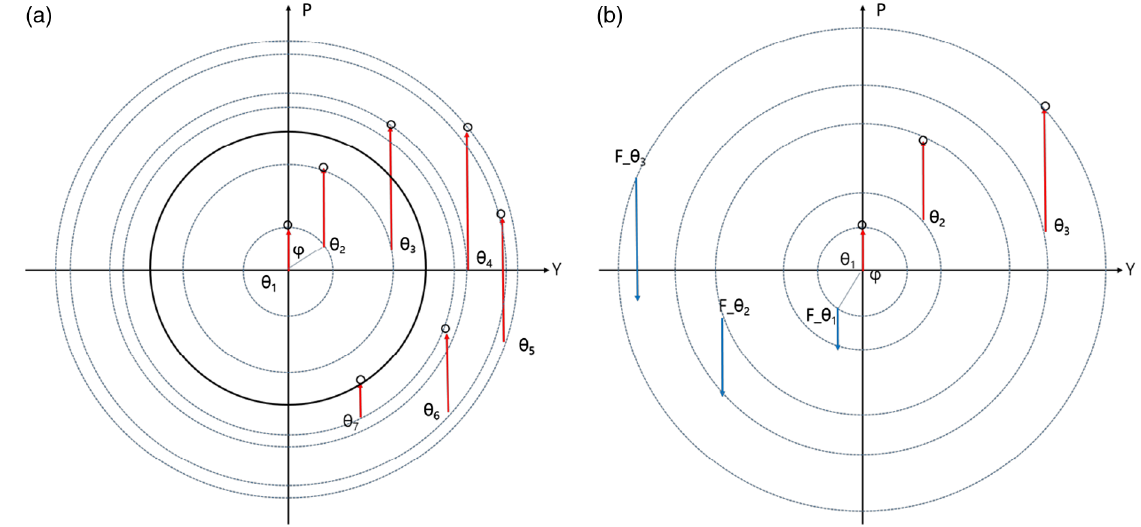
FIG. 3. Stored-beam motion in normalized coordinates. (a) Schematics of the beam oscillation by the leakage field from the septum magnet. θ is the kick by the leakage field; the subscript is the turn number; φ is the phase advance after one turn. (b) Schematics of the beam oscillation by the leakage field and fast counterkicker. Here φ is the phase advance between the septum magnet and fast counterkicker. F θ is the kick by the fast counterkicker. Each dot represents the motion of the centroid of 100 000 particles along turns.